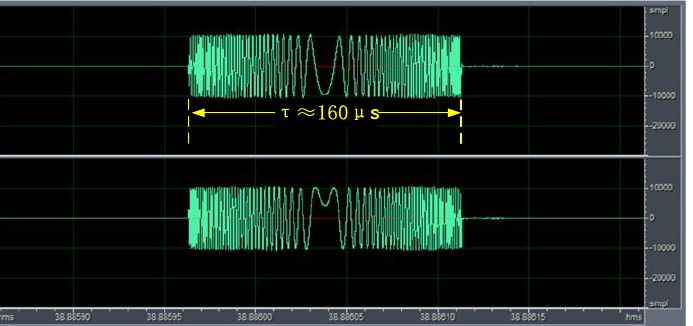
after partial magnification.